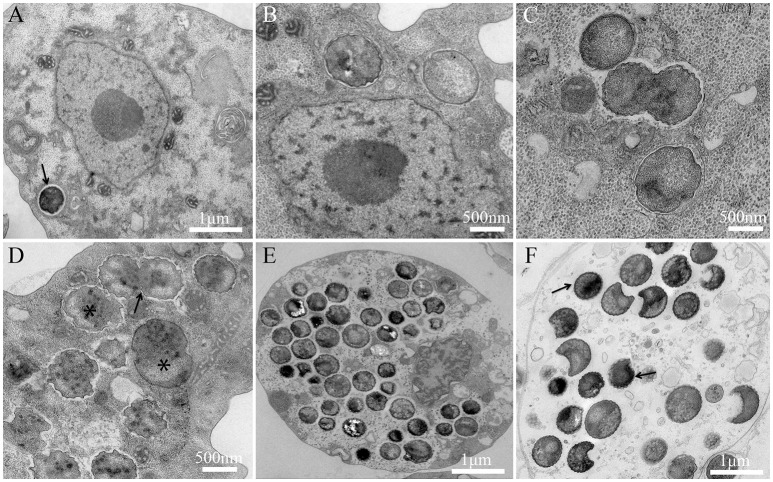
Developmental cycle of P. massiliensis in V. vermiformis. (A) Internalization of a phagocytized P. massiliensis elementary body (EB), by a trophozoite of V. vermiformis at H0 p.i. (B) Ultrathin section of an amoeba harboring reticulate bodies (RBs) near the nucleus undergoing the replicative stage, where an increase in size and a decrease in density can be observed. (C), (D) Replicative stage at H12, H16, H18 p.i showing an increased number of P. massiliensis particles and hypodense RBs at different stages of morphogenesis (asterisks in D marking RBs. Some bacteria at the typical binary fission stage are also observed (black arrow in D showing typical binary division, and the constriction of some RBs can be observed). (E), (F) End of the replicative stage where, after growth and binary division, the RBs start reorganizing and condensing to form infectious EBs showed by black arrows. Different stages of the P. massiliensis developmental cycle can be detected, and RBs and EBs can be observed simultaneously, scattered inside in the host cytoplasm.